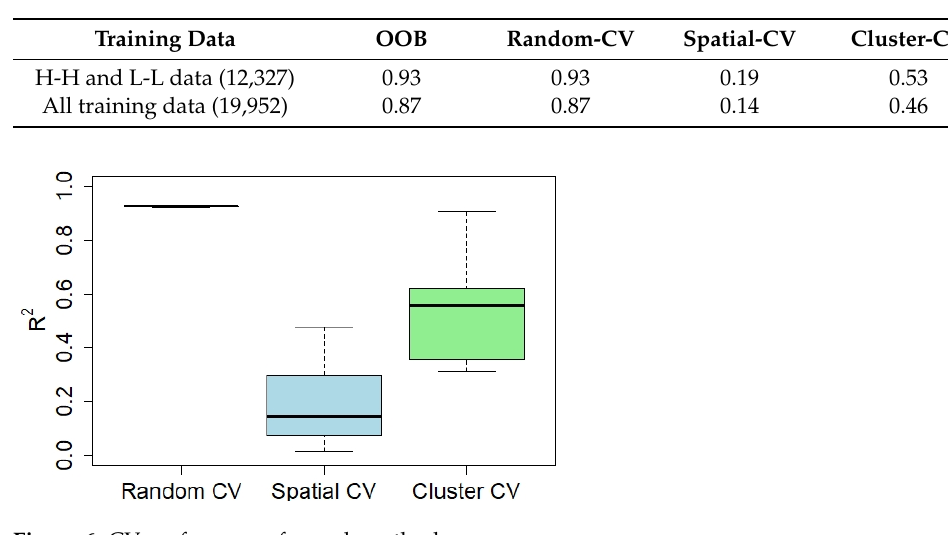
Figure 6. CV performance for each